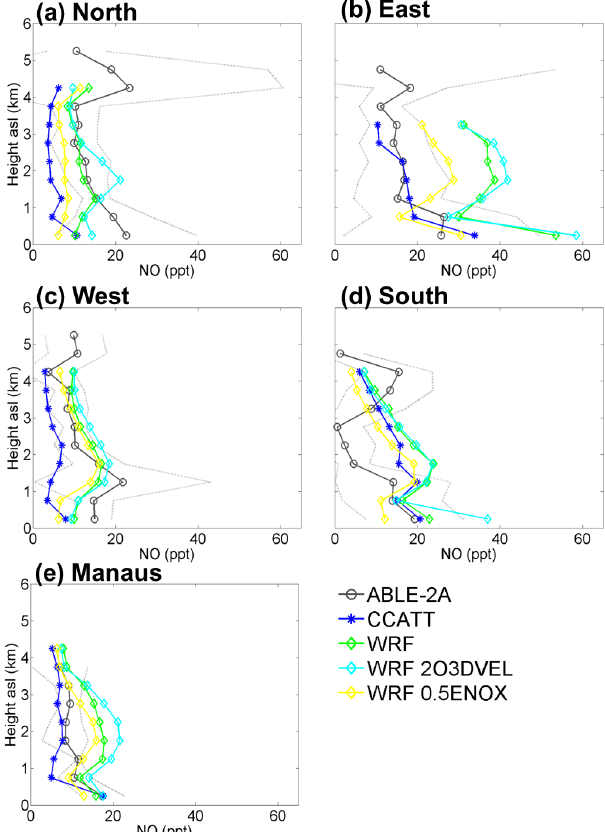
Figure 12. Mean vertical O 3 profiles for BARCA A flights for ob- servations (black, gray line denotes 1 standard deviation), CCATT- BRAMS (blue), and WRF-Chem (base case: green, 2DEPVEL: cyan, and 0.5ENOx: yellow) simulations by region: (a) north, (b) east, (c) west, (d) south, and (e) around Manaus. ABLE-2A observations (gray) from the same regions are included for com- parison.